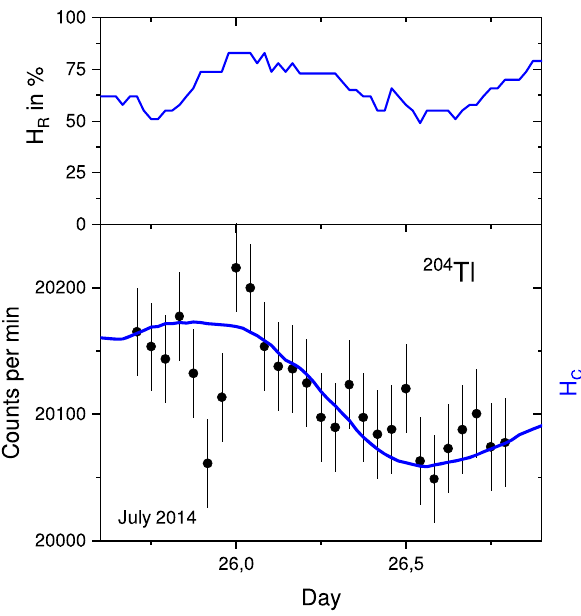
Fig. 5 Relative humidity in the Valencia region (top) in the period 25– 26 July 2014 [68]. Qualitative comparison (bottom) of measured 204 Tl decay rates [27,29] with the accumulated-humidity model H C ( t ; ¯ H R = 75% ,(cid:3) t = − 7h ) in Eq.